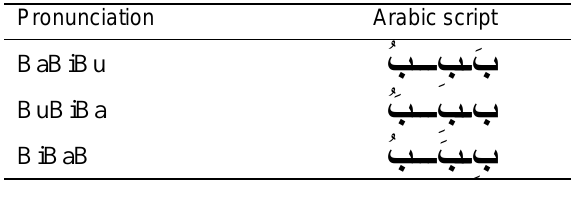
Figure 3. Identifying letters in a word by spacing